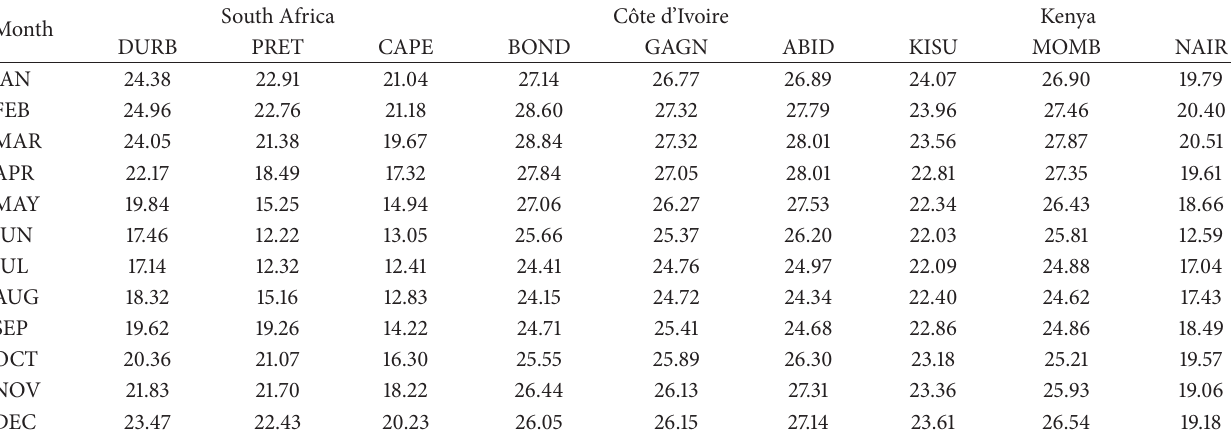
Table 1: Monthly means for each